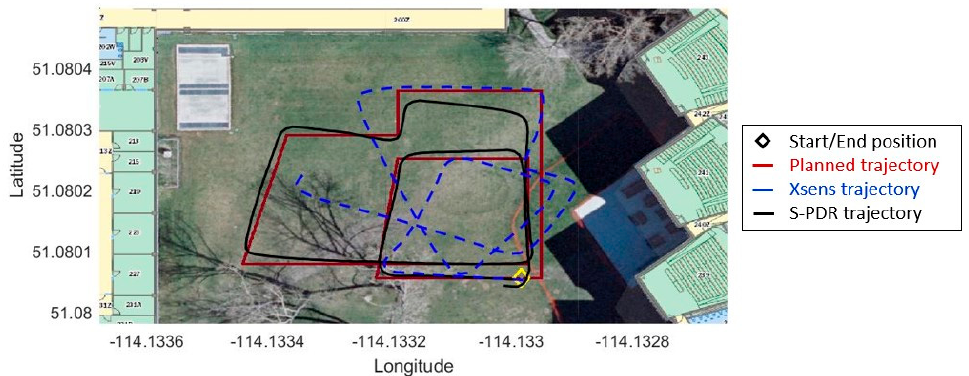
Figure 23. Outdoor reference trajectory and reconstructed trajectory using S-PDR and Xsens.